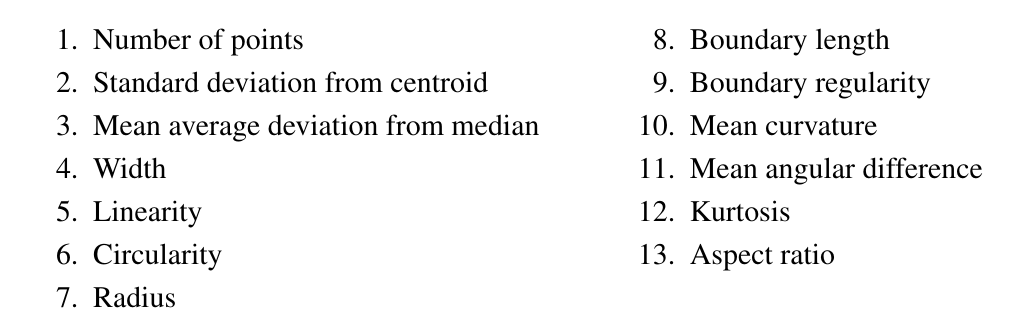
Table 1. List of the laser feature basis.